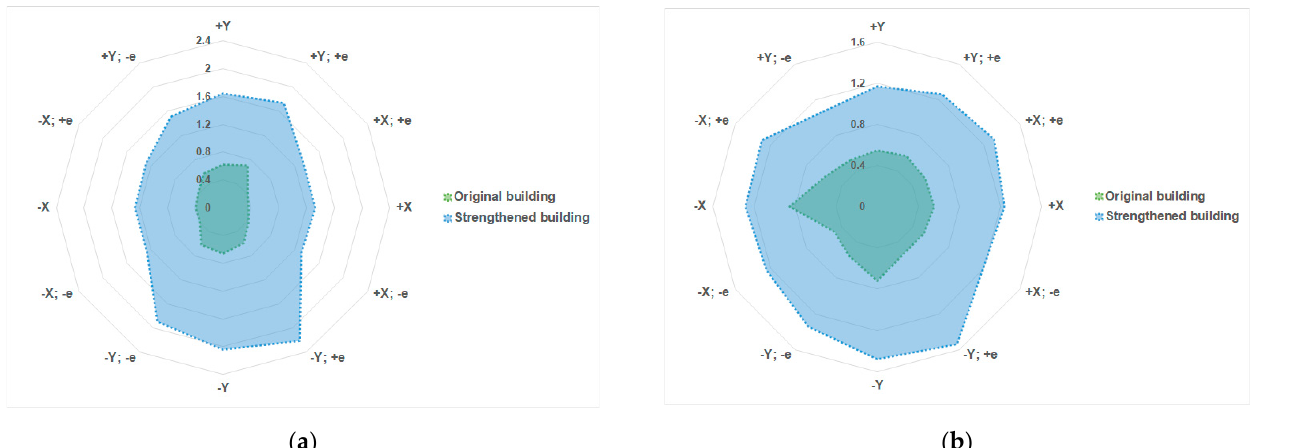
Figure 22. Comparison of α values for the original building and strengthened building for ( a ) uniform load distribution; ( b ) modal load distribution.